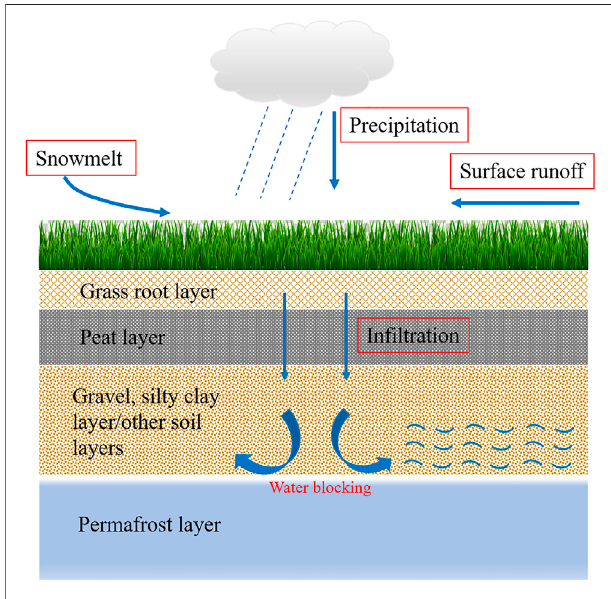
FIGURE 2 | Schematic of PWs pro fi